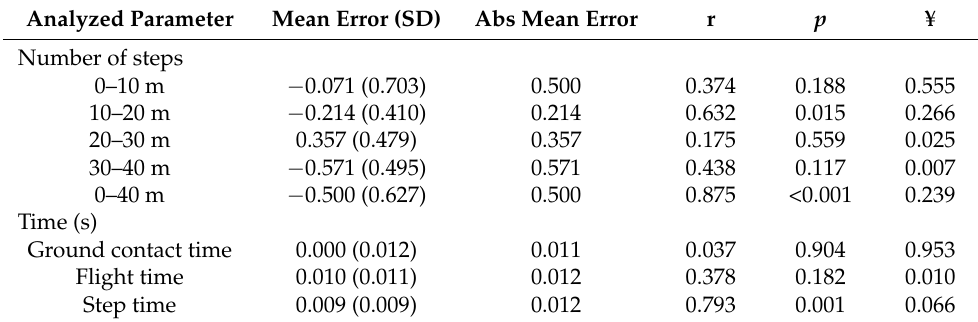
Table 2. An accuracy comparison between the inertial measurement unit (IMU) and high-speed